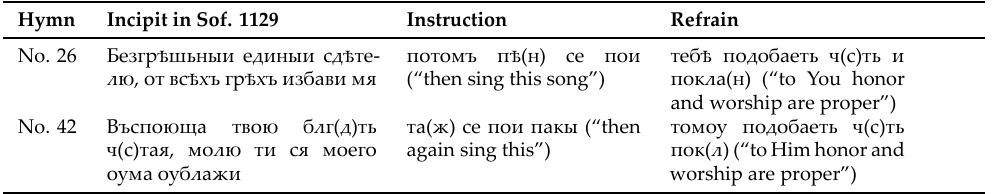
Table 4. The kata stichon hymns of the pervosopnitsa in St. Petersburg, RNB MS Sof. 1129.